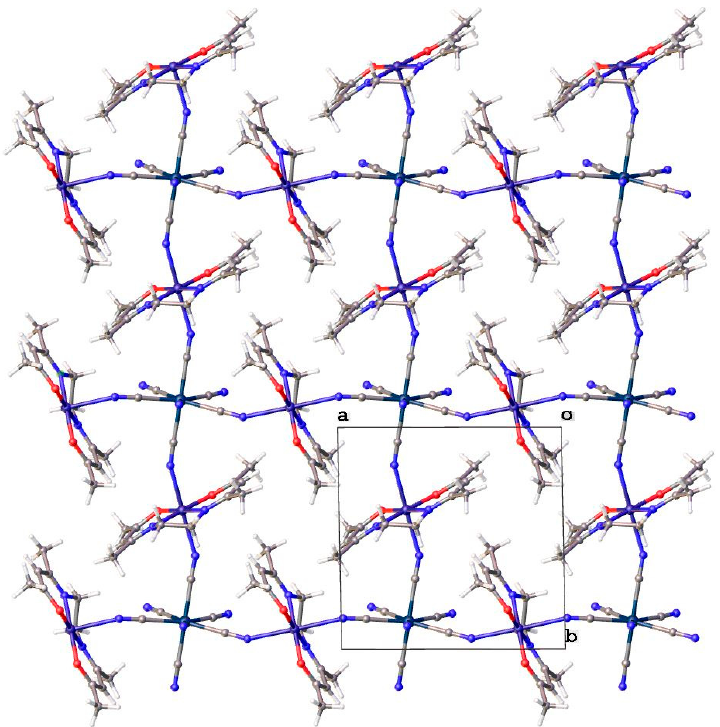
Figure 19. Projection of the anionic layer along the c axis of 15 , showing a two-dimensional network structure consisting of two types of crossed chains [56].